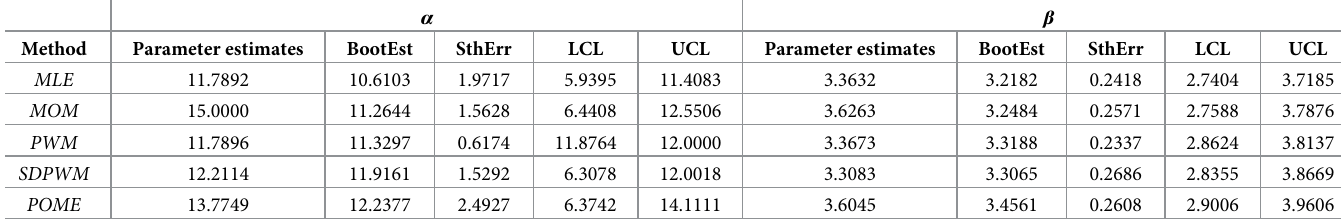
Table 2. Parameter estimates, standard error, length and coverage of a 95% confidence interval based on bootstrap re-samples from the maximum flood level data in million of feet 3 /second.